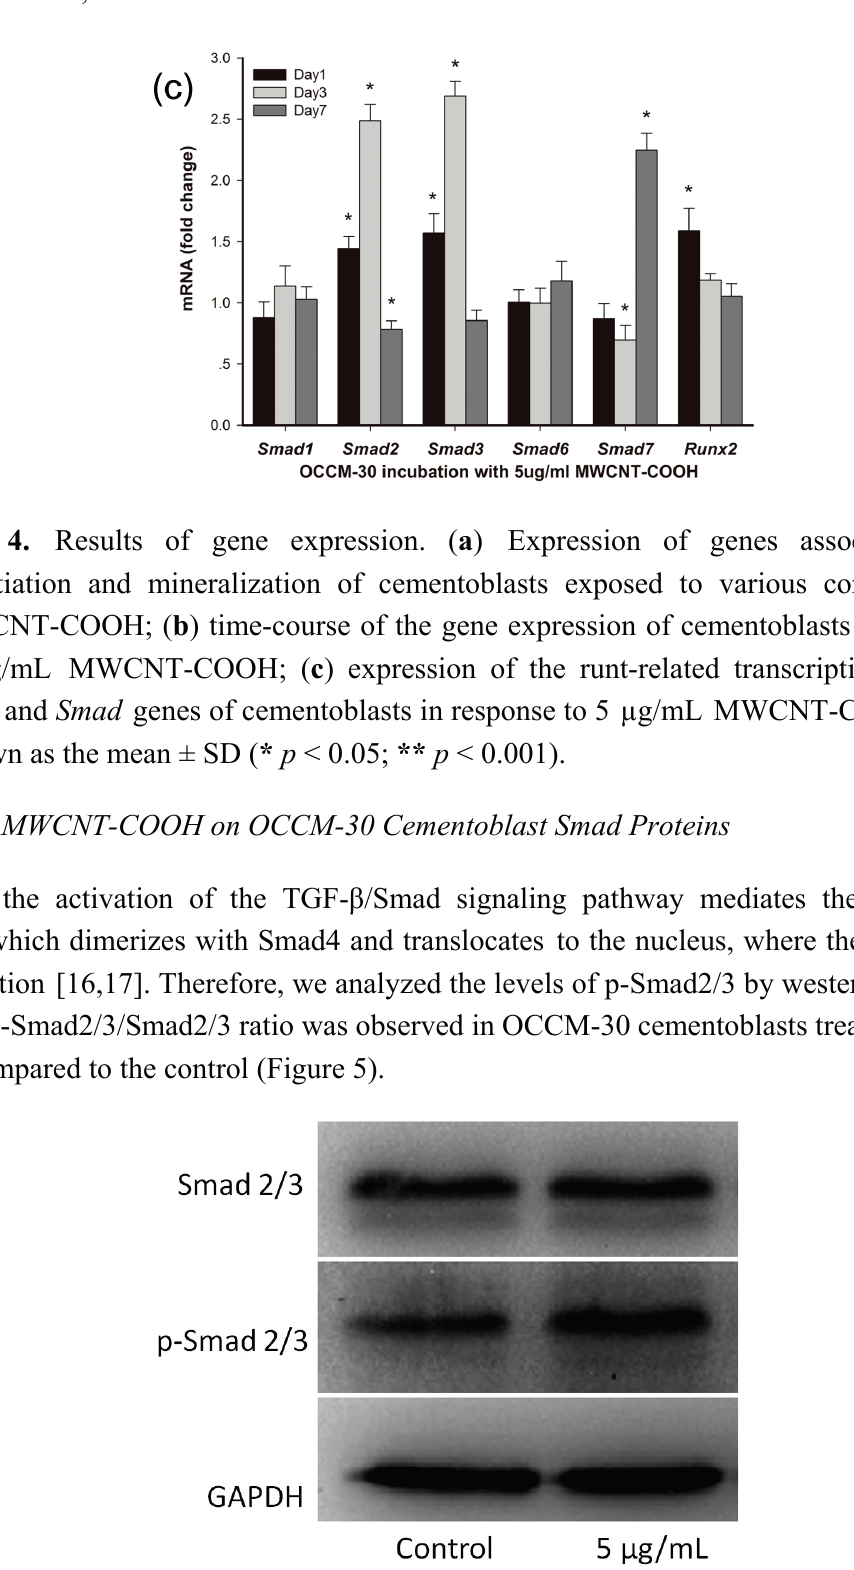
Figure 5. Effects of MWCNT-COOH on Smad proteins by western blot. On Day 3, increased p-Smad2/3 was observed in cementoblasts treated with 5 µg/mL MWCNT-COOH compared to the